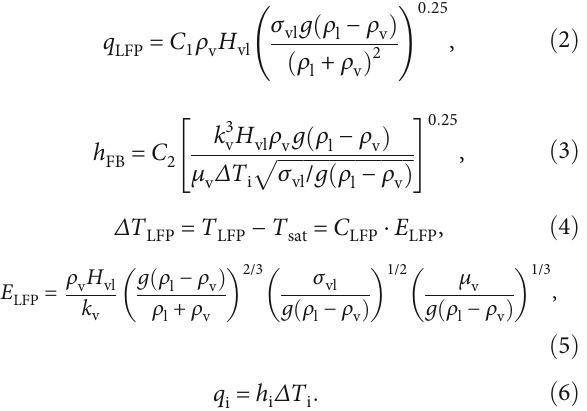
Figure 6: Tested data curves for Exp. 1 (0.45 kg/s, P